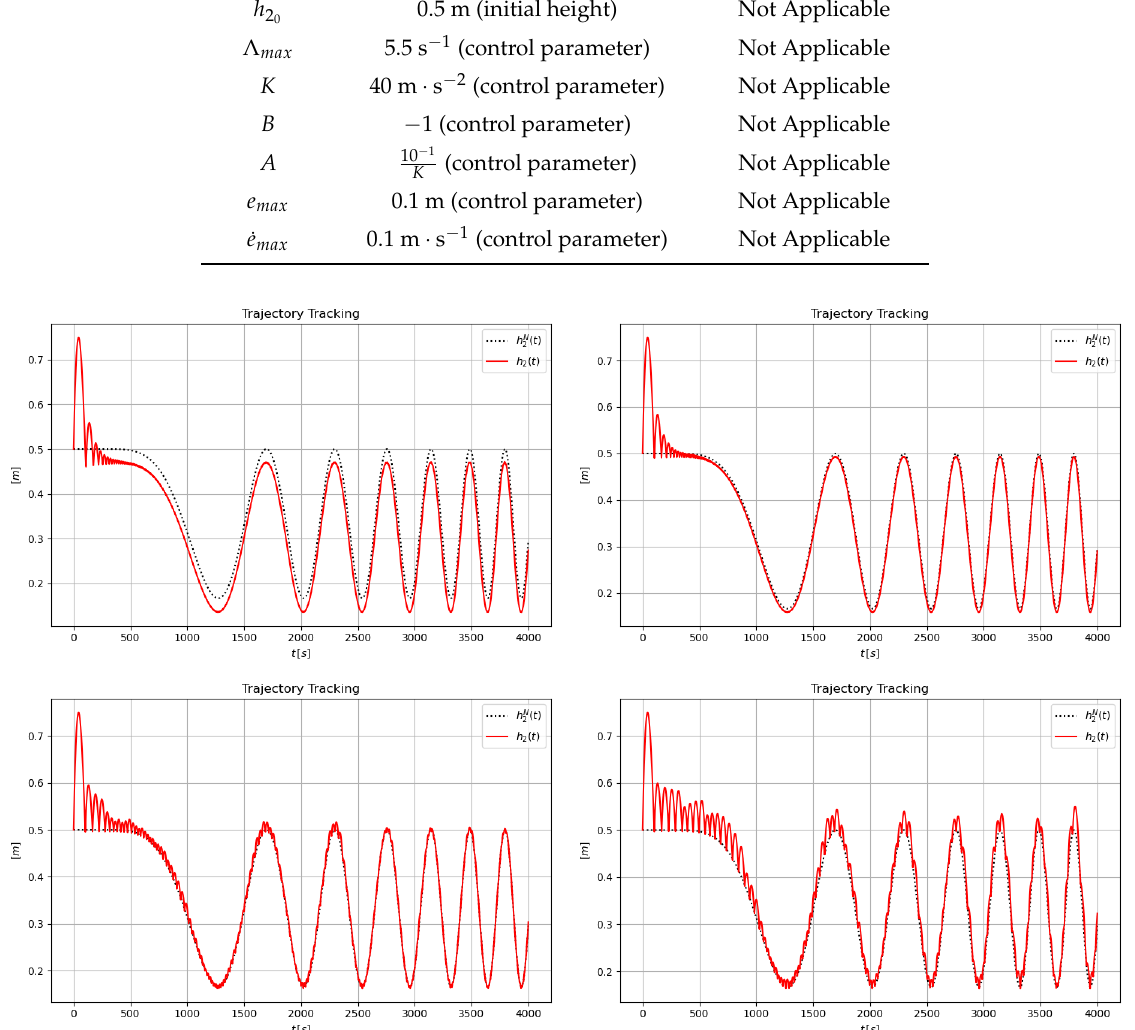
Figure 2. Trajectory tracking for ( Λ max = 1 (upper Left Hand Side), 4 (upper Right Hand Side), 9 (bottom Left Hand Side), 12 (bottom Right Hand